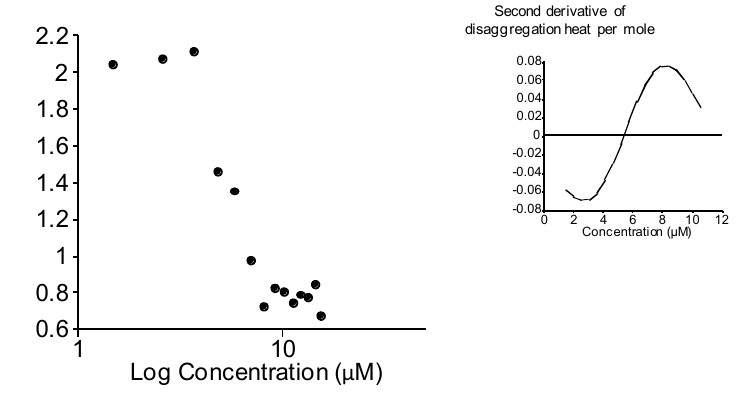
Figure 5. Critical aggregation concentration (CAC) of bolaamphiphile 1 determined by ITC measurements. The graph show the heat of disaggregation per mole of 1 plotted versus the concentration logarithm of the bolaform in the ITC cell. Inset: second derivative of the disaggregation heat as a function of